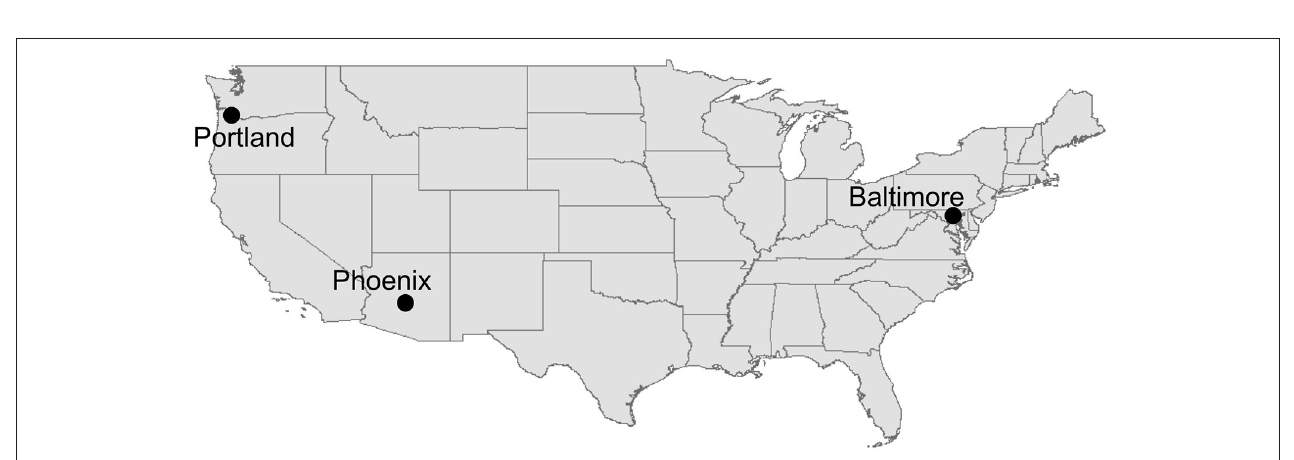
FIGURE 1 | Eco-techno spectrum representing the range of different types of landscape features which play a role in urban stormwater management.